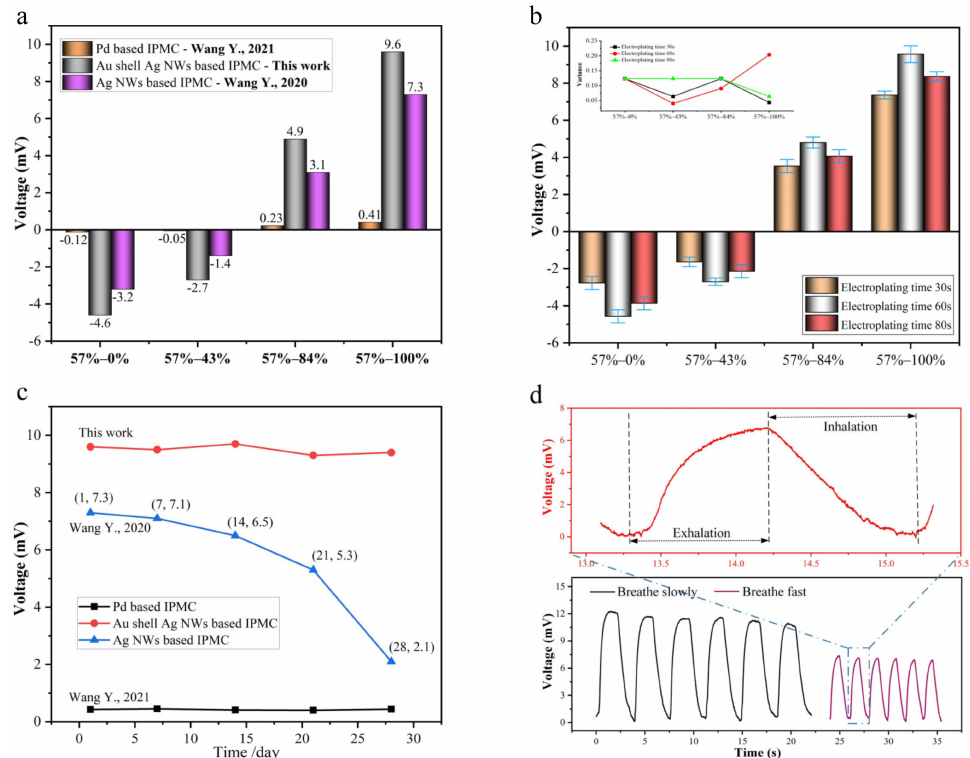
Figure 7. Voltage response of different samples from 57% RH to 100% RH. ( a ) Samples based on dif- ferent preparation processes [11,18]. ( b ) Samples based on different electrodepositing times. ( c ) Long- term stability of the peak voltage [11,18]. ( d ) Breathing test using Au-shell-Ag-NW-based